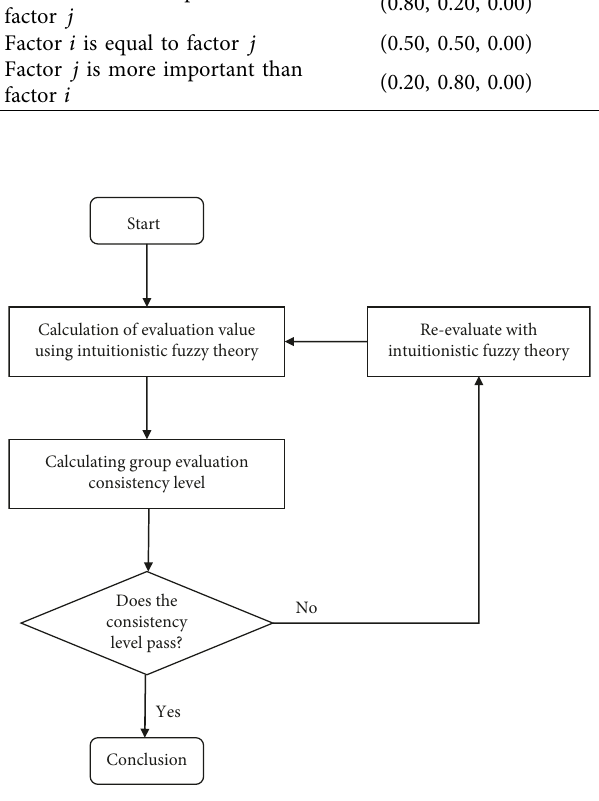
Figure 5: Process of consistency test.